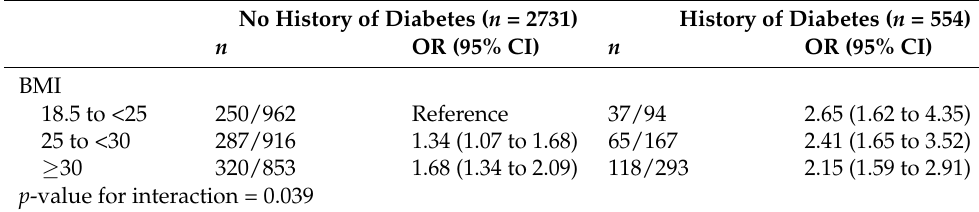
Table 4. Interaction between BMI and history of